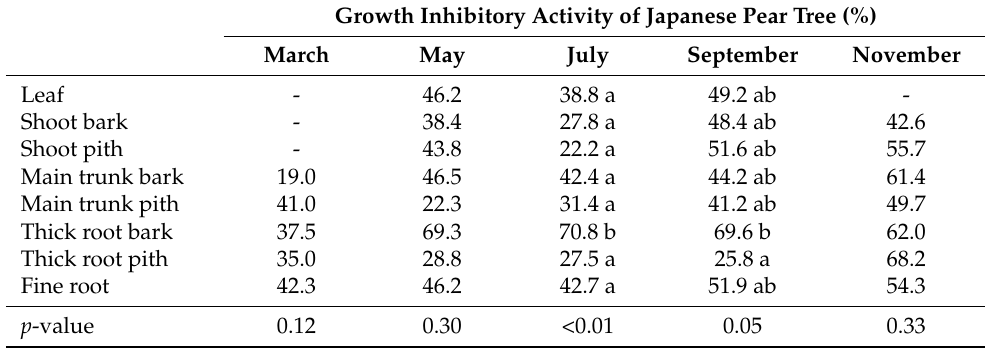
Table 1. Changes in the growth inhibitory effects of the tissue type of Japanese pear tree. Growth Inhibitory Activity of Japanese Pear Tree (%)